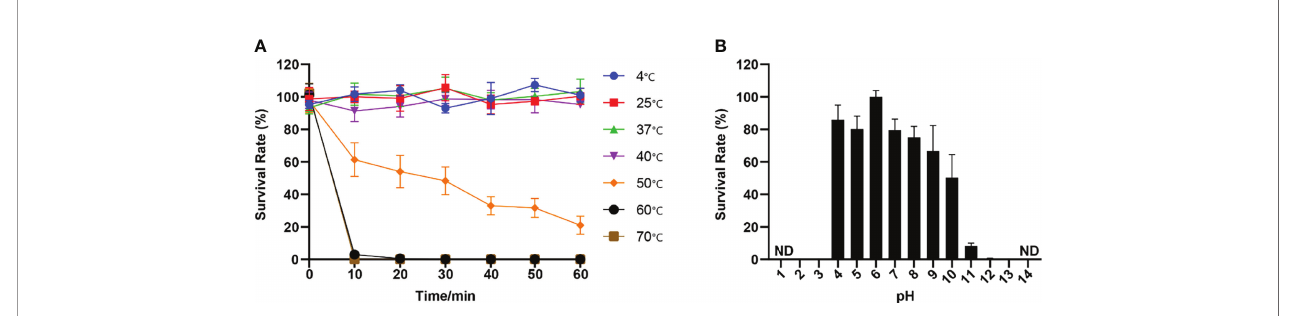
FIGURE 4 | Thermal and pH stability of vB_kpnM_17-11. (A) Temperature stability of phages vB_kpnM_17-11. When incubated at different temperatures for 60 min, the phages could survive at 4°C, 25°C, 37°C and 40°C. At 50°C, the phage concentration decreased by 80%. Phages could not survive at 60°C and 70°C. Data were obtained from three independent experiments and are shown as mean ± standard deviation. (B) PH stability of phages vB_kpnM_17-11. vB_kpnM_17-11 was incubated at the indicated pH conditions for 60 min. vB_kpnM_17-11 is relatively stable under neutral condition. The phage titer decreased signi fi cantly under